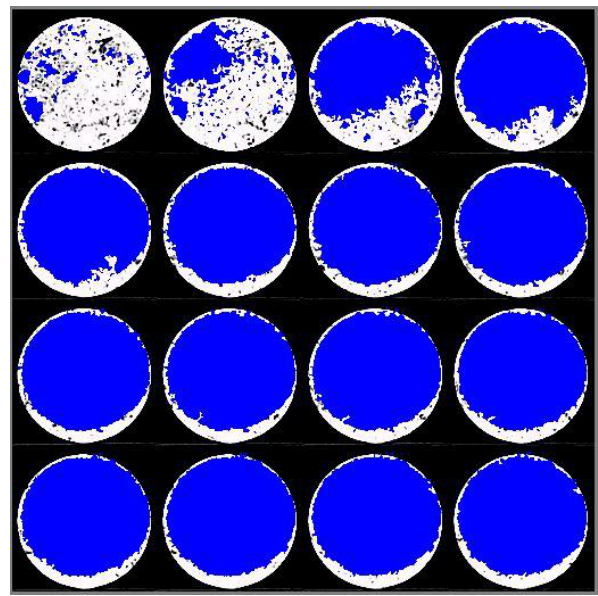
Figure 8. Superimposed patterns of the fresh ( white ) and burnt ( blue ) sample reveal the shrinkage of the sample after 6 h of exposure.